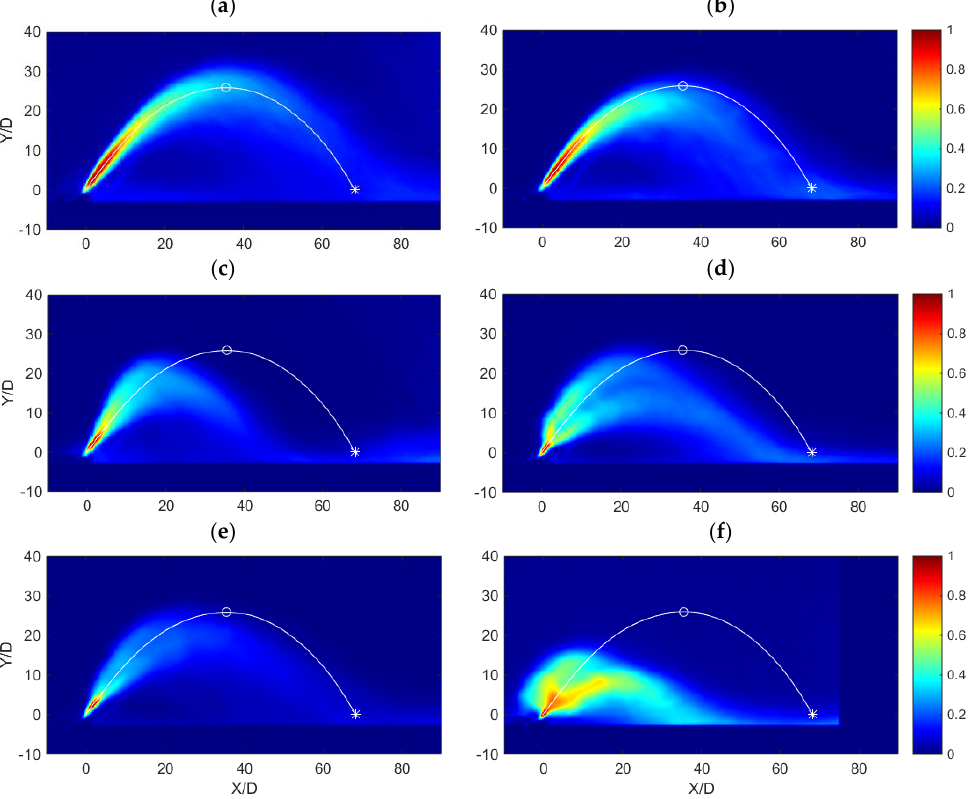
Figure 10. Non-dimensional mean concentration fields for an NBJ with Fr = 18.0 released into a receiving body affected by regular waves with T = 0.0 s and A = 0.0 mm (stagnant case, a ), T = 0.5 s and A = 5.0 mm ( b ), T = 1.0 s and A = 5.0 mm ( c ), T = 1.0 s and A = 12.5 mm ( d ), T = 1.5 s and A =